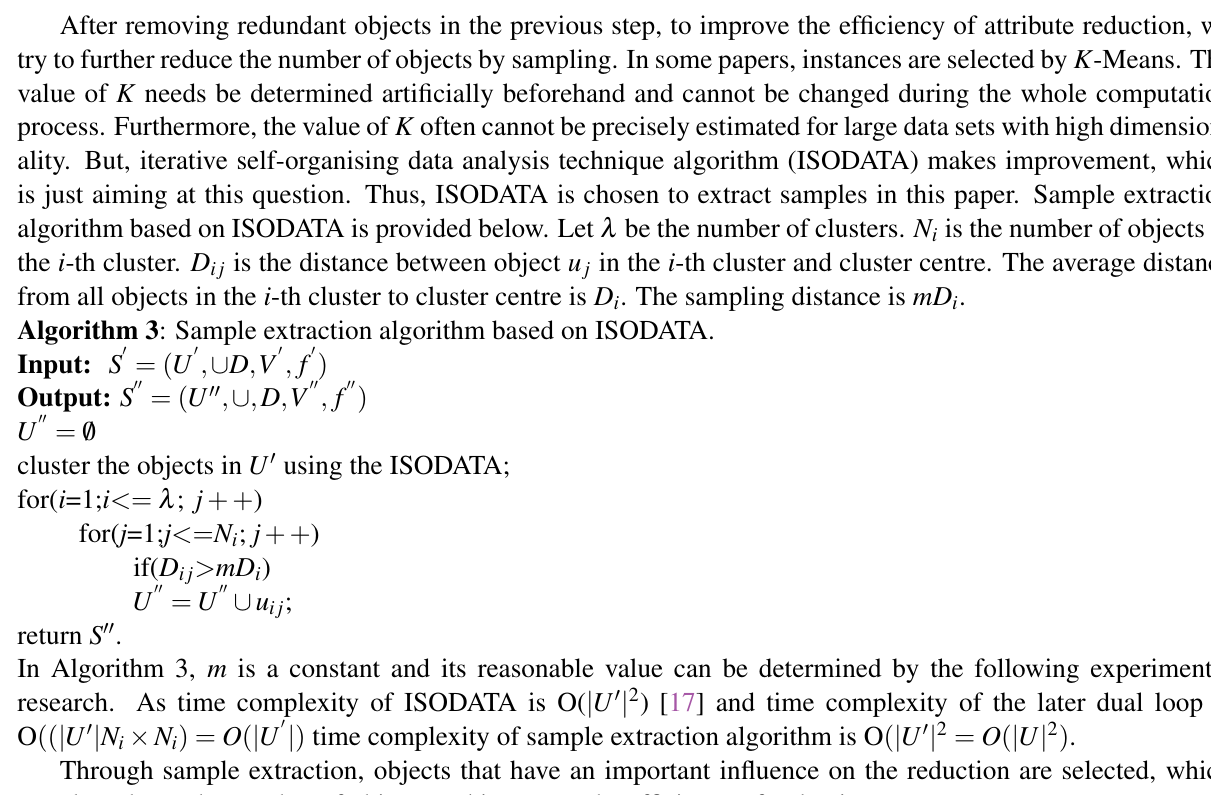
Algorithm 3 : Sample extraction algorithm based on